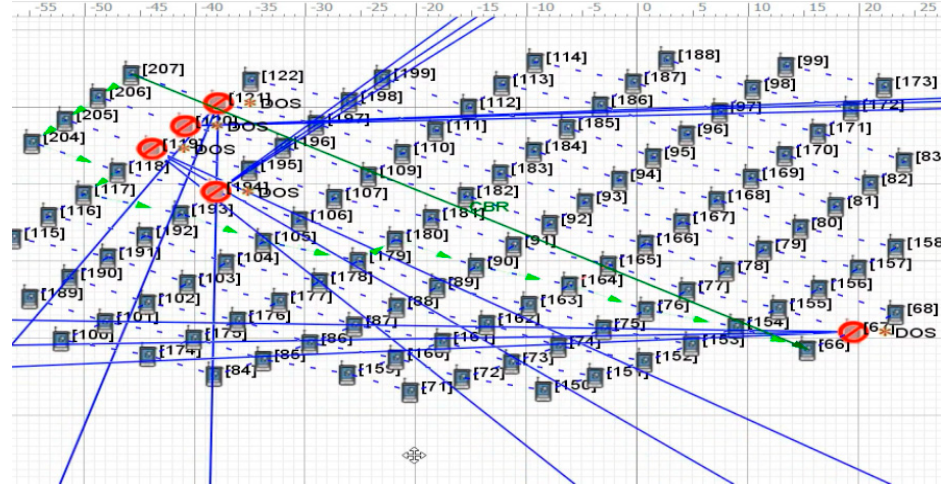
Figure 8. Average end–to–end delay under four–satellite–key–node attack scenario.